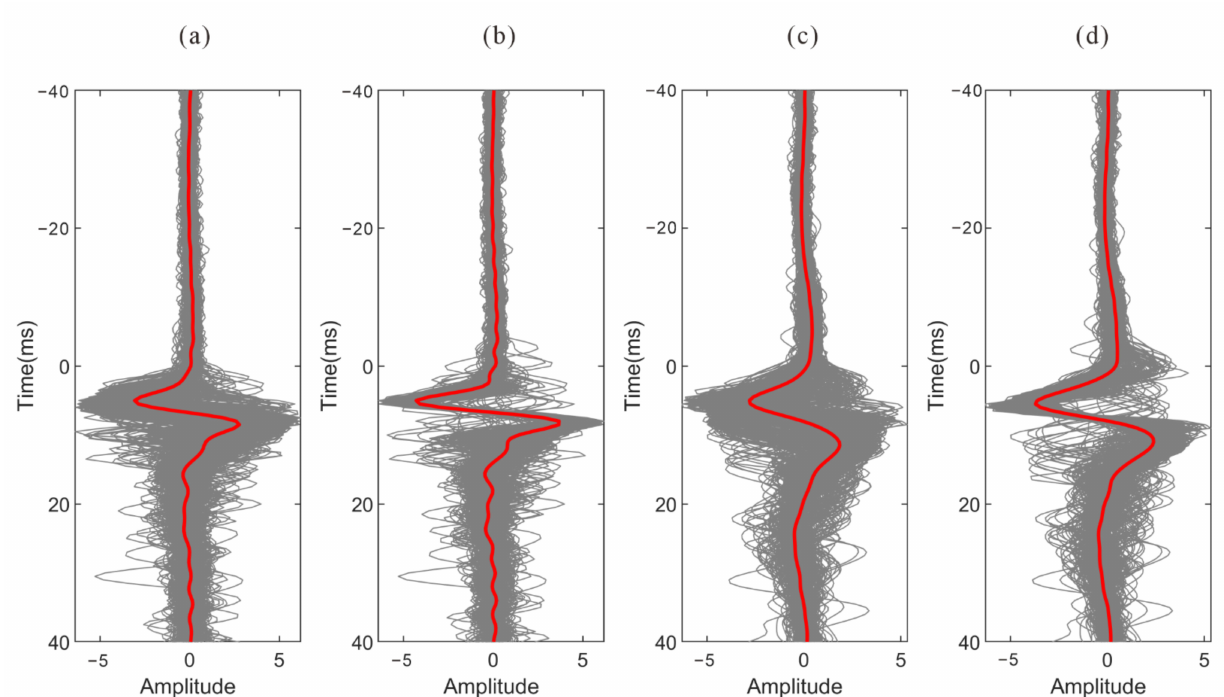
Figure 19. The stacked waveforms of all events before and after inter-event refinement. ( a ) P wave stacked waveforms before inter-event refinement; ( b ) P wave stacked waveforms before inter- event refinement; ( c ) S wave stacked waveforms before inter-event refinement; ( d ) S wave stacked waveforms after inter-event refinement. The red lines are the final stacked waveforms.